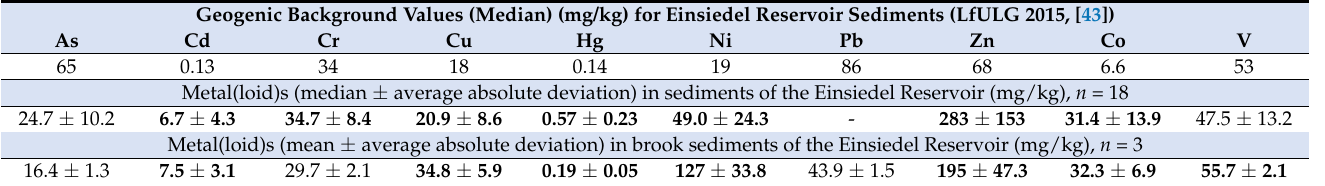
Table 2. Comparison between the medians of geogenic background values for Saxon topsoils on phyllite (land use: forestry) [43] and the measured metal(loid) concentrations in the reservoir and brook sediments of the Einsiedel Reservoir. Values in bold exceed the background concentrations.